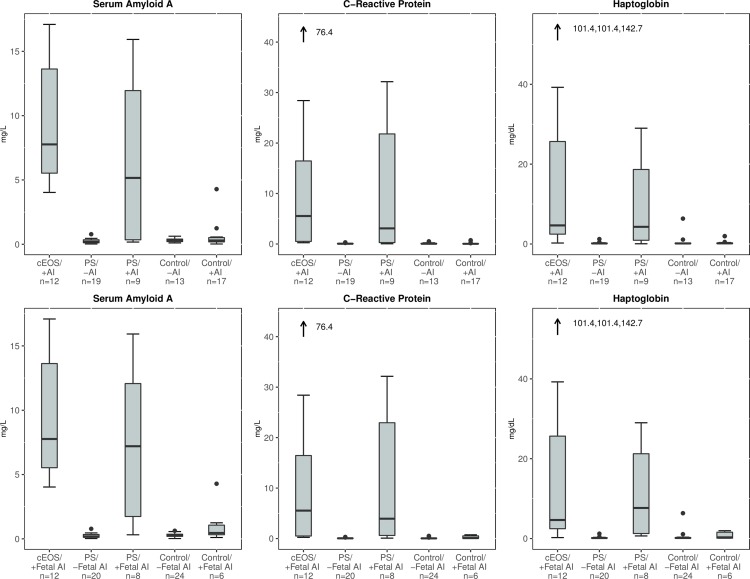
Serum amyloid A, C-reactive protein, and haptoglobin levels in sepsis groups by AI.Box and whisker plots displaying distribution of 3 APR biomarkers (SAA, CRP, Hp) in each sepsis category with and without fetal AI [bottom row] and any placental AI (maternal and/or fetal) [top row].